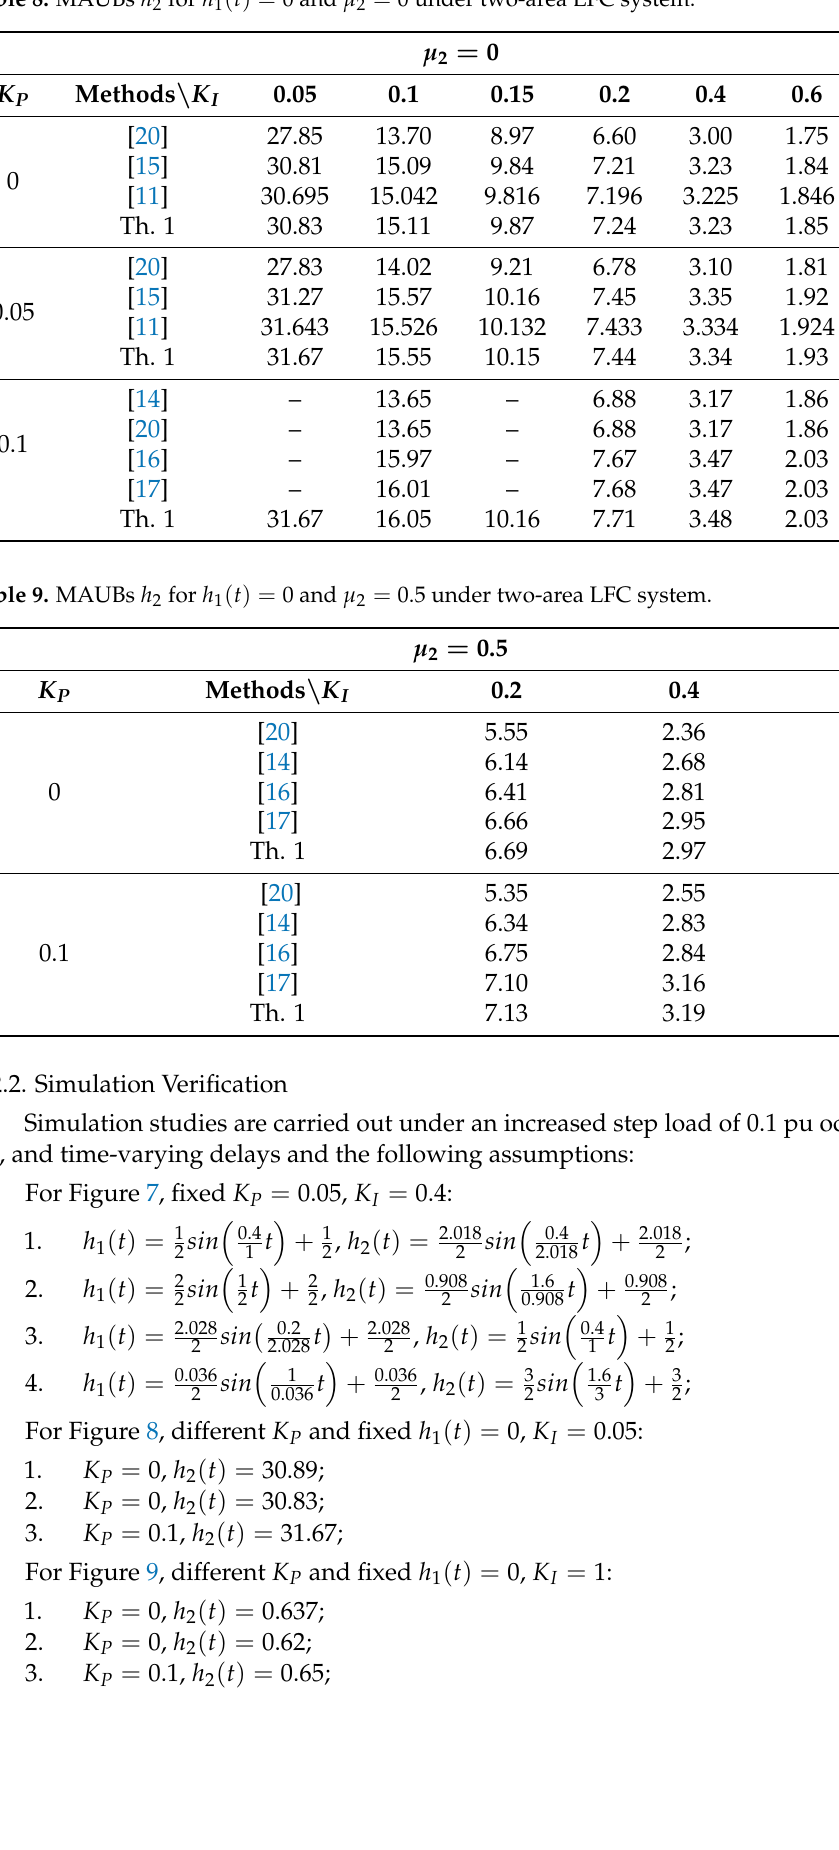
Table 8. MAUBs h 2 for h 1 ( t ) = 0 and µ 2 = 0 under two-area LFC system.